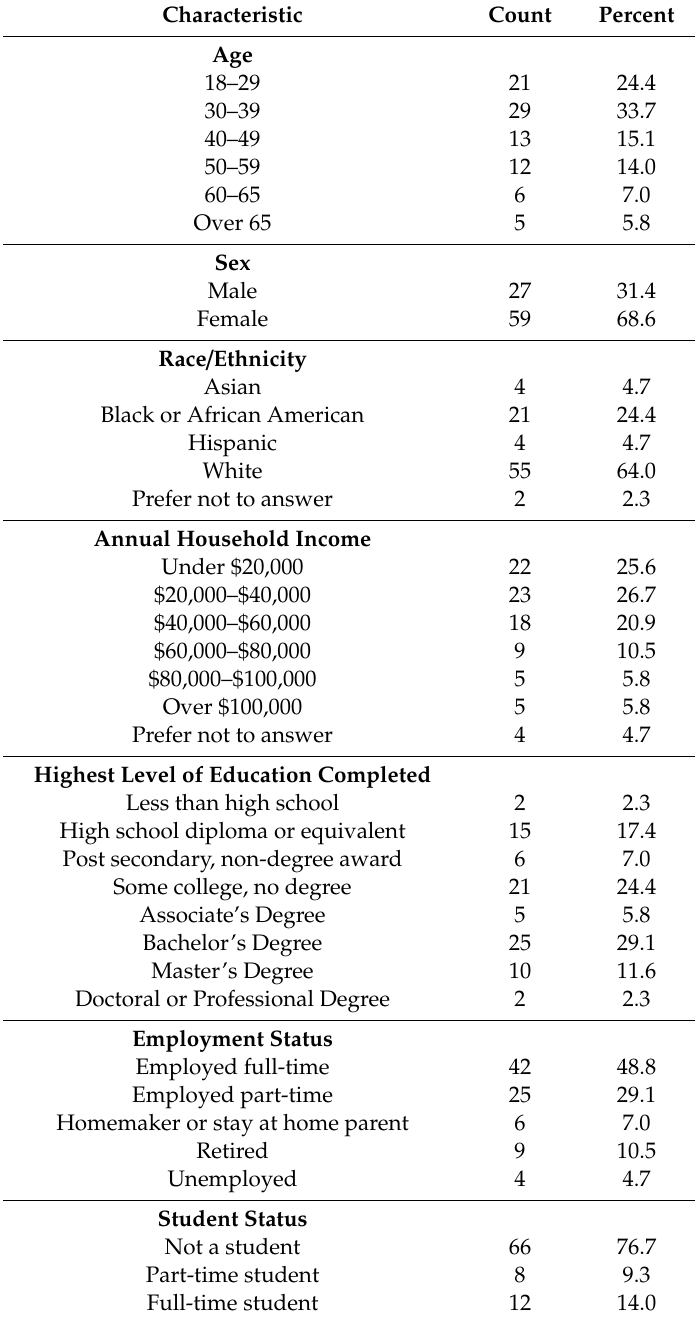
Table 1. Demographic and socioeconomic characteristics of survey